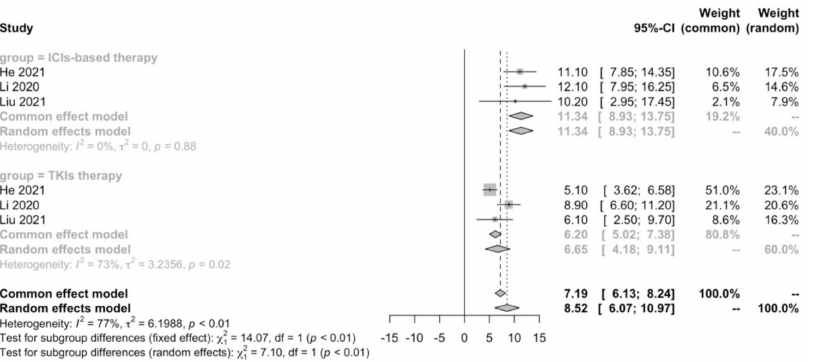
Figure 2. Meta-analysis of PFS in advanced HCC patients receiving first-line ICIs-based therapy versus TKIs